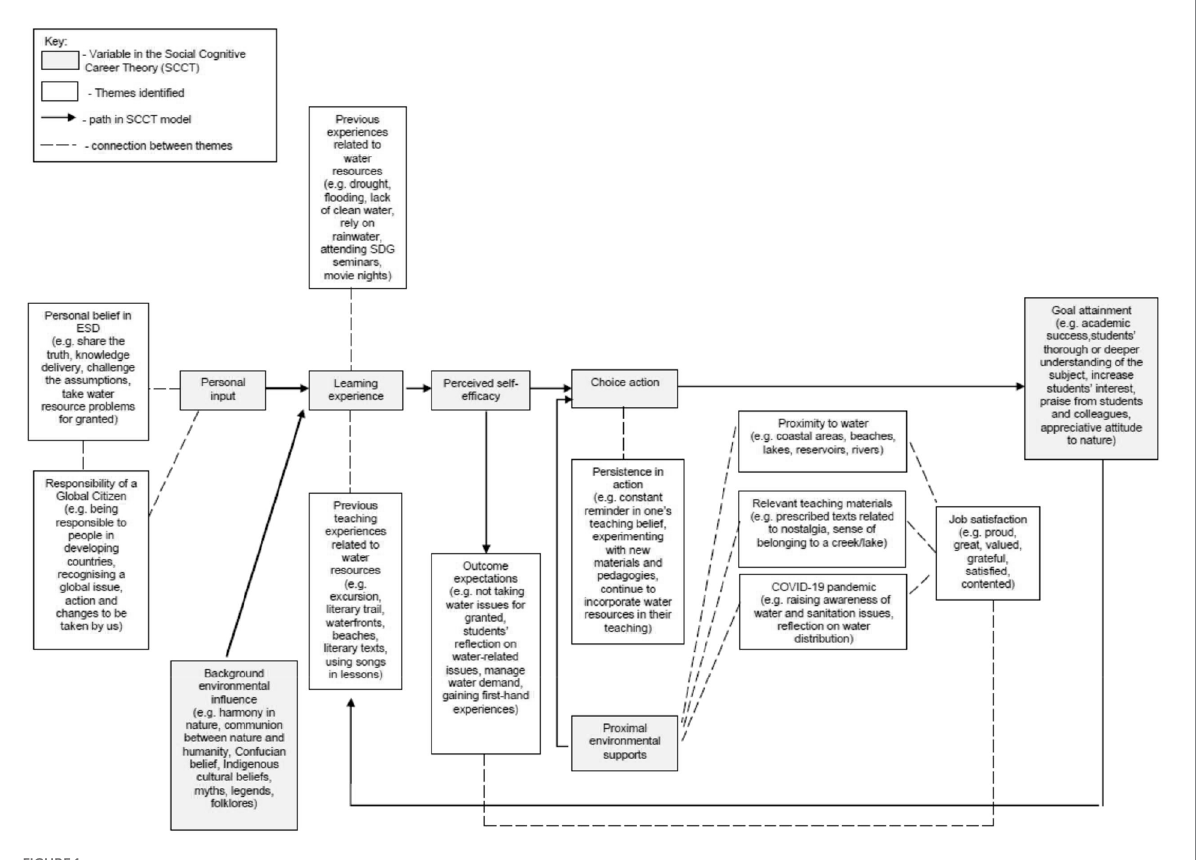
FIGURE 1 Thought process of theme and subtheme generation.